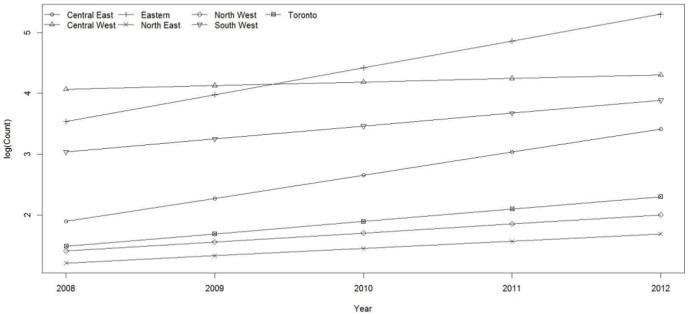
Trends in Ixodes scapularis counts in Ontario, Canada, by region (2008–2012).